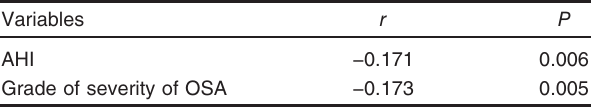
Table 4 Correlation between obstructive sleep apnea severity and irritable bowel syndrome